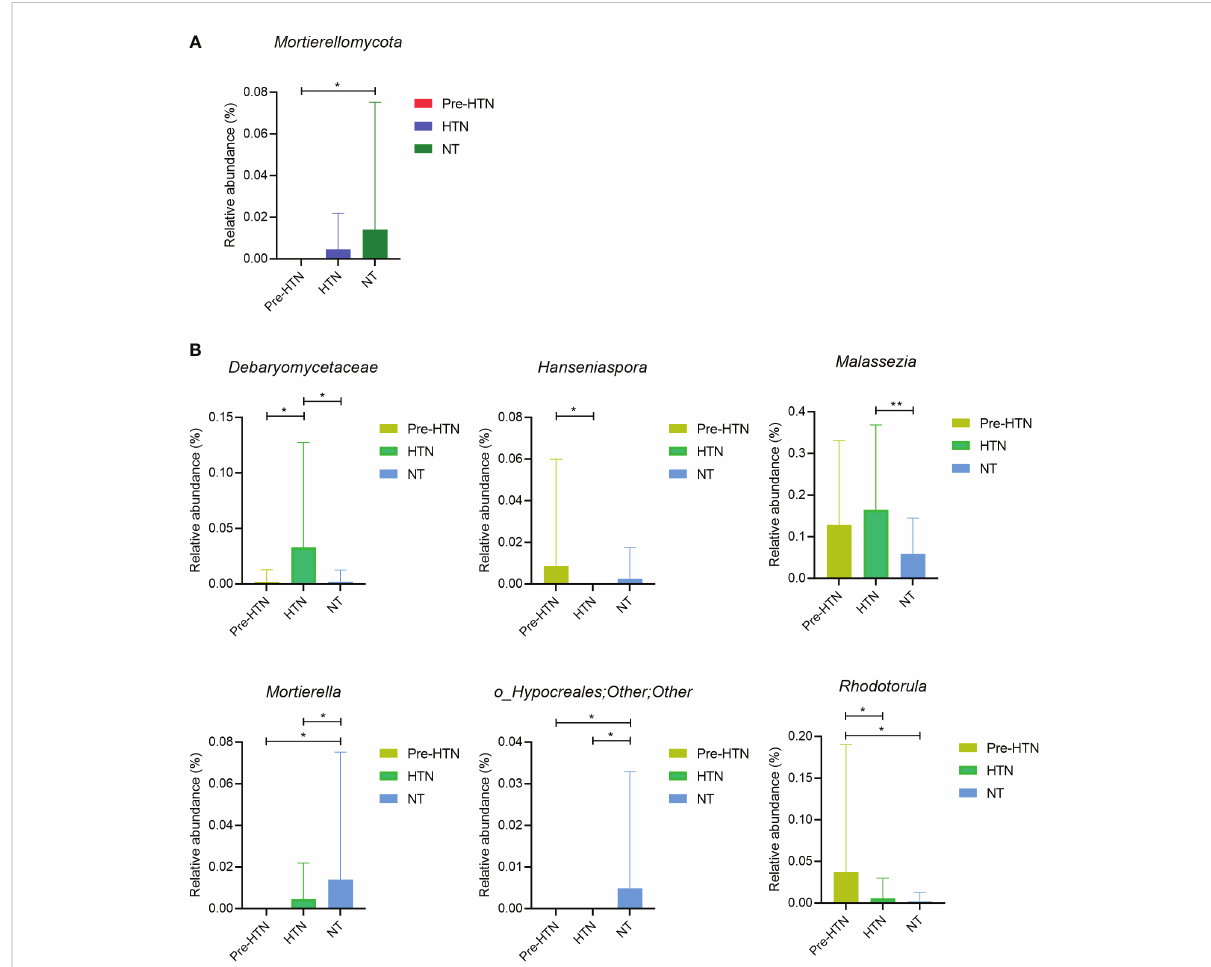
FIGURE 2 Fungal phyum and genus that were differentially abundant among groups of pre-HTN, HTN and NT. (A) Bacterial phylum signi fi cantly different among groups of pre-HTN, HTN and NT. (B) Bacterial genera signi fi cantly signi fi cantly different among groups of pre-HTN, HTN and NT. P value was calculated using Wilcoxon rank-sum test and adjusted by Benjamini and Hochberg FDR. *FDR < 0.05; and